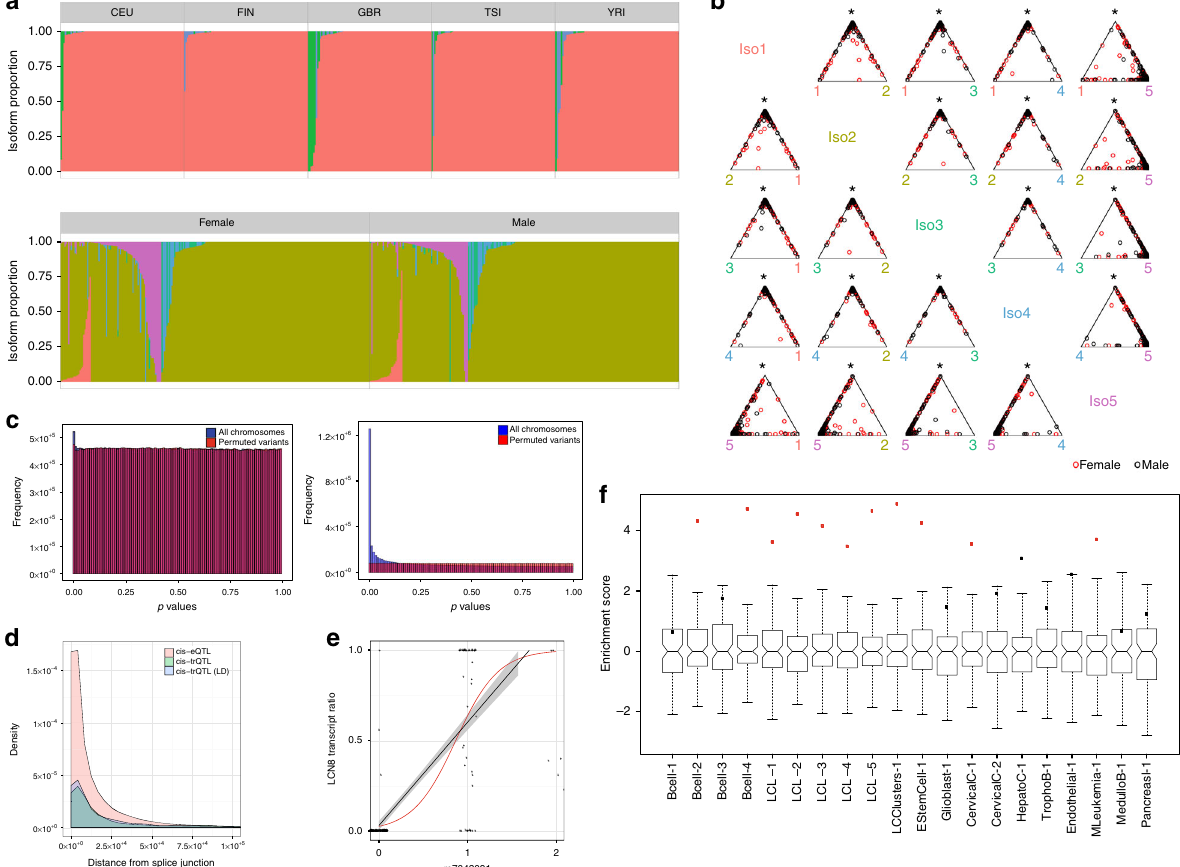
Fig. 5 Results for isoform quanti fi cation in the GEUVADIS data. a The isoform quanti fi cation distribution where color denotes a unique isoform and each vertical bar is a single sample for genes PTPRN2 (top) and LGALS9B (bottom). b Simplex plots for gene LGALS9B factored by sex. Each point (red for female, black for male) represents a sample ’ s isoform composition for the two isoforms denoted on the bottom axis and the remaining isoforms at the top intersection point. c Matrix eQTL p value distribution for (left) cis-trQTLs and (right) cis-eQTLs. d The density of cis-trQTLs, LD pruned cis-trQTLs, and cis- eQTLs distances to the nearest canonical splice junctions in GENCODE. e LCN8 contained the most signi fi cant cis-trQTL ( p ≤ 2.2 × 10 − 16 ). Linear and logistic regressions are shown in black and red. f Enrichment of cis-trQTLs variants in cis-regulatory annotations across cell types. Box plots show the distribution of a matched null set with Tukey whiskers (median ± 1.5 times interquartile range) and red points denoting signi fi cant enrichment (VSE test, Bonferroni-corrected p ≤